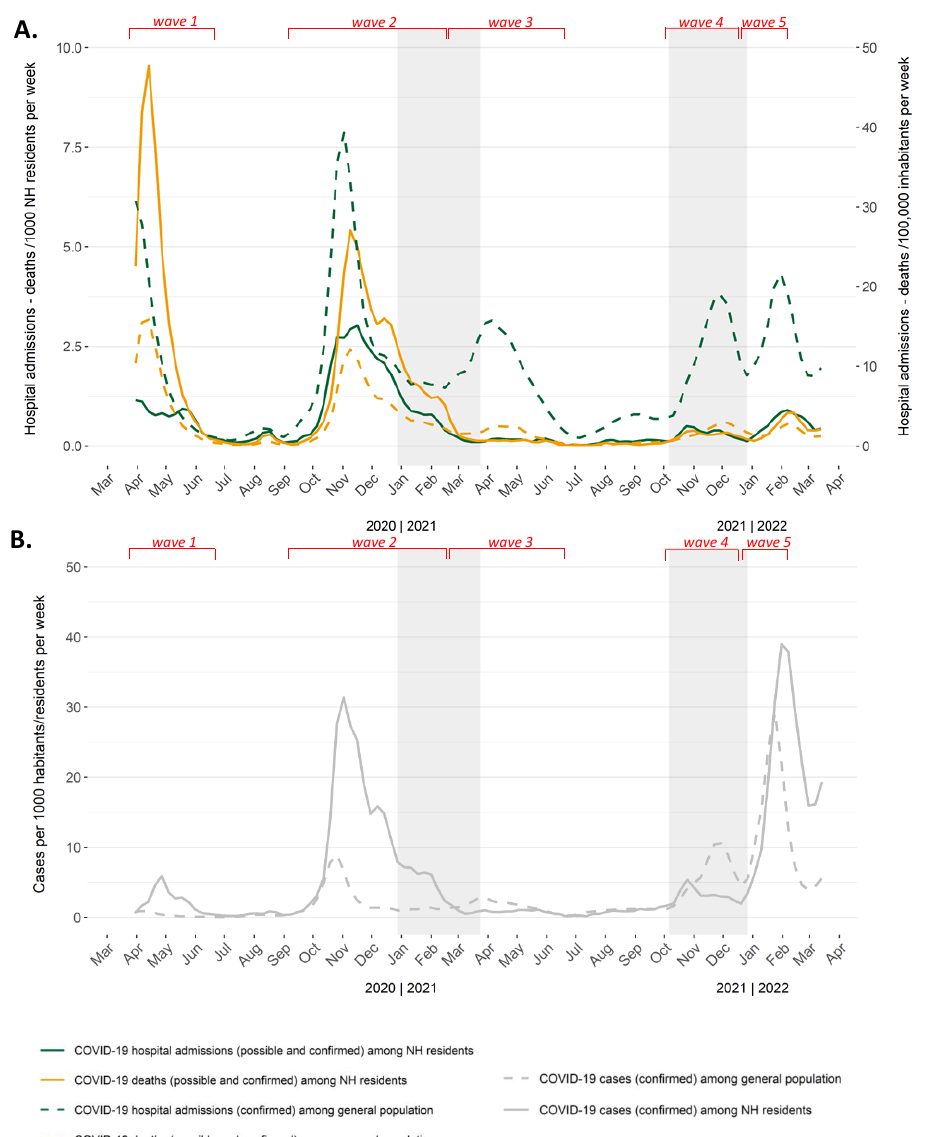
Figure 1: A. Hospital admissions and deaths per 1000 nursing home (NH) residents (left y axis) and hospital admissions and deaths per 100,000 inhabitants (including NH residents) (right y axis), per week (two-week moving average), 6 March 2020 – 20 March 2022. B. Confirmed cases per 1000 nursing home (NH) residents and confirmed cases per 1000 inhabitants (including NH residents), per week (two-week moving average), 6 March 2020 – 20 March 2022. Grey boxes indicate the COVID-19 vaccination campaign and the booster administration in NH.